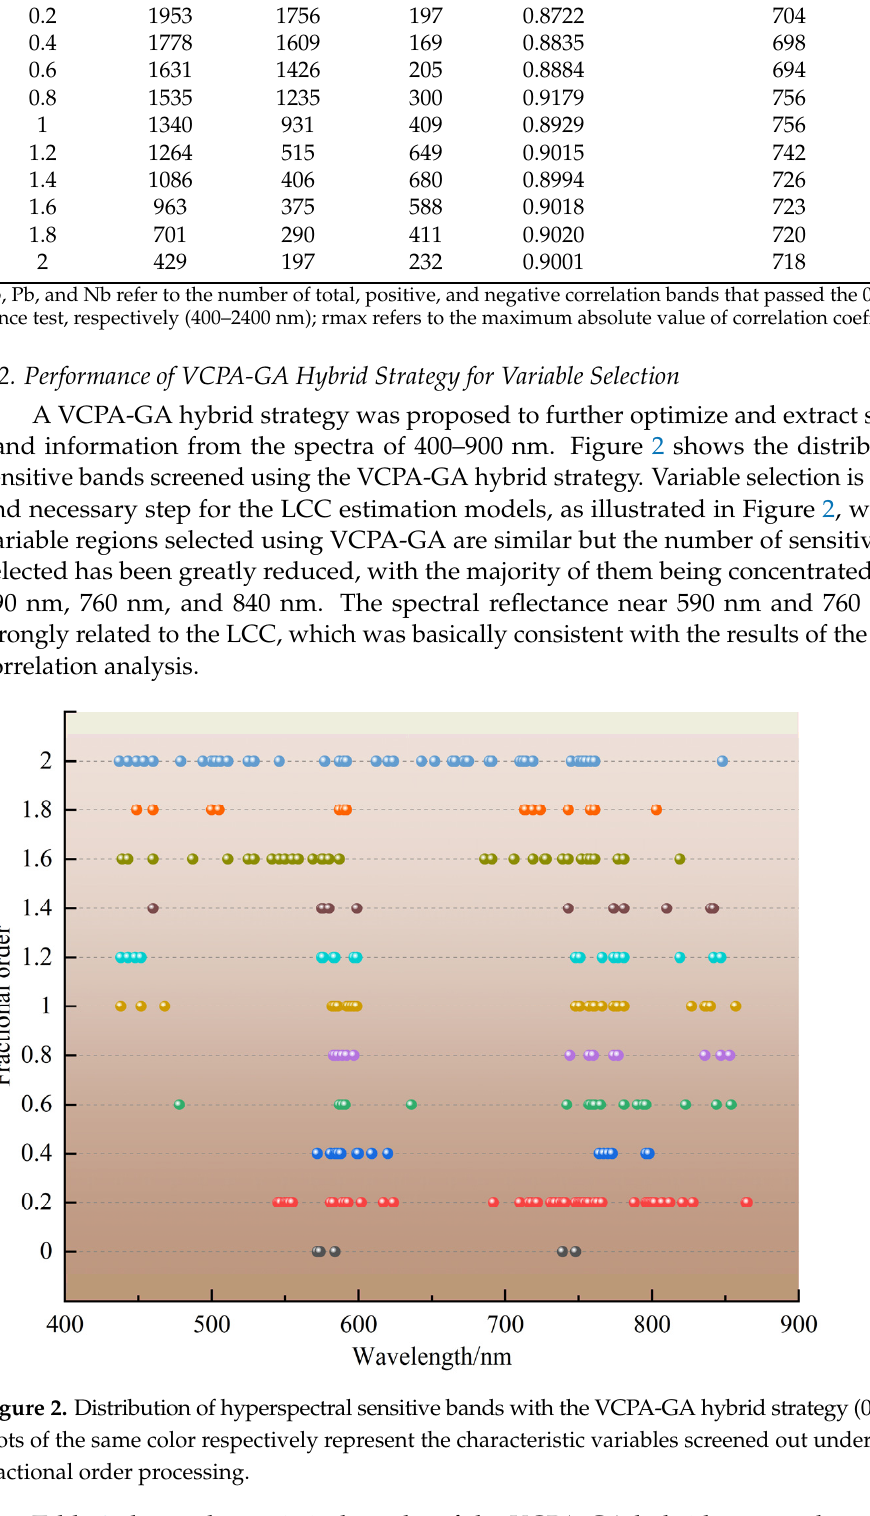
Table 2. Statistical table of the number of spectral bands passing the 0.01 significance test (0–2 order).